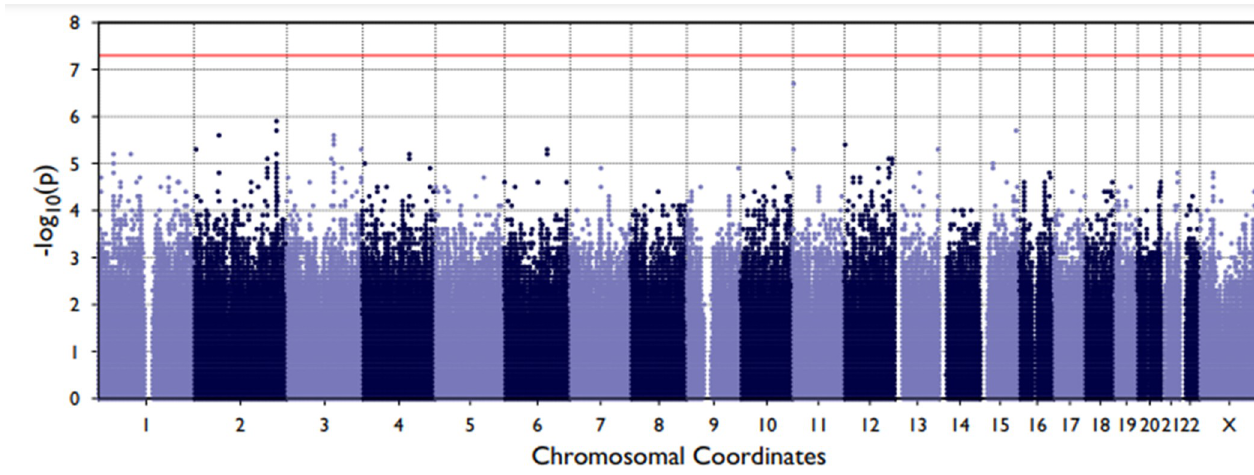
Fig 4. Manhattan plot showing the single nucleotide polymorphisms and their univariate p-values for Sepsis-3.